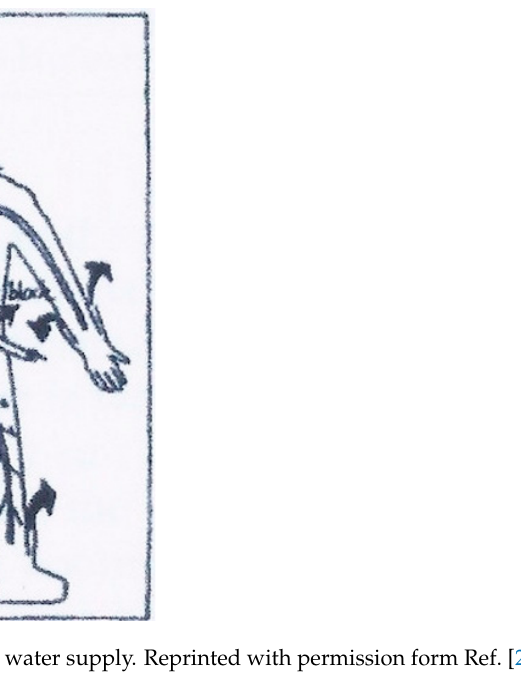
Figure 10. Dry suit with hot water supply. Reprinted with permission form Ref. [29]. Copyright 2004 Prof. Hans Örnhagen, SE.